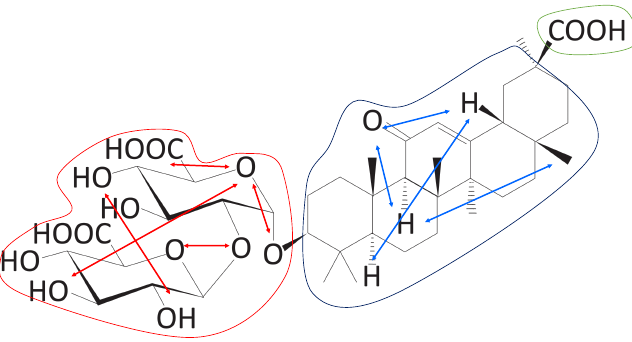
Figure 13. Within-block distance (Score 2). Red arrows represent the distance between groups belonging to Block A. Blue arrows represent the distance between groups belonging to Block B. In this case, Block C has only one group. These distances were used to measure Score 2 (Algorithm